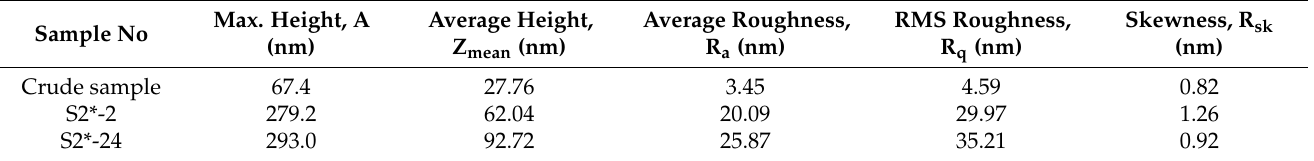
Table 7. Surface roughness parameters of cadmium chalcogenide layers chalcogenized in 0.1 mol/L solution of H 2 TeS 4 O 6 at 25 ◦